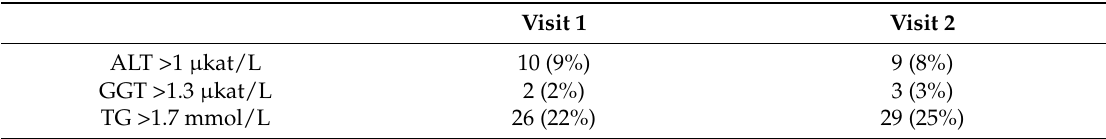
Table 6. Number (percentage) of participants with values of ALT, GGT or TG higher than upper reference